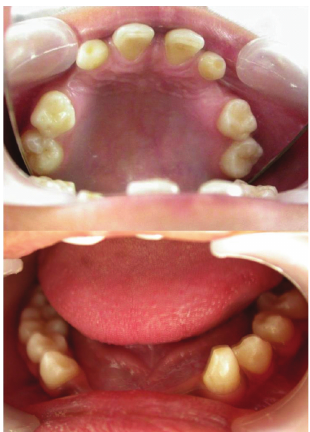
Figure 3: Upper and lower arch showing missing teeth.